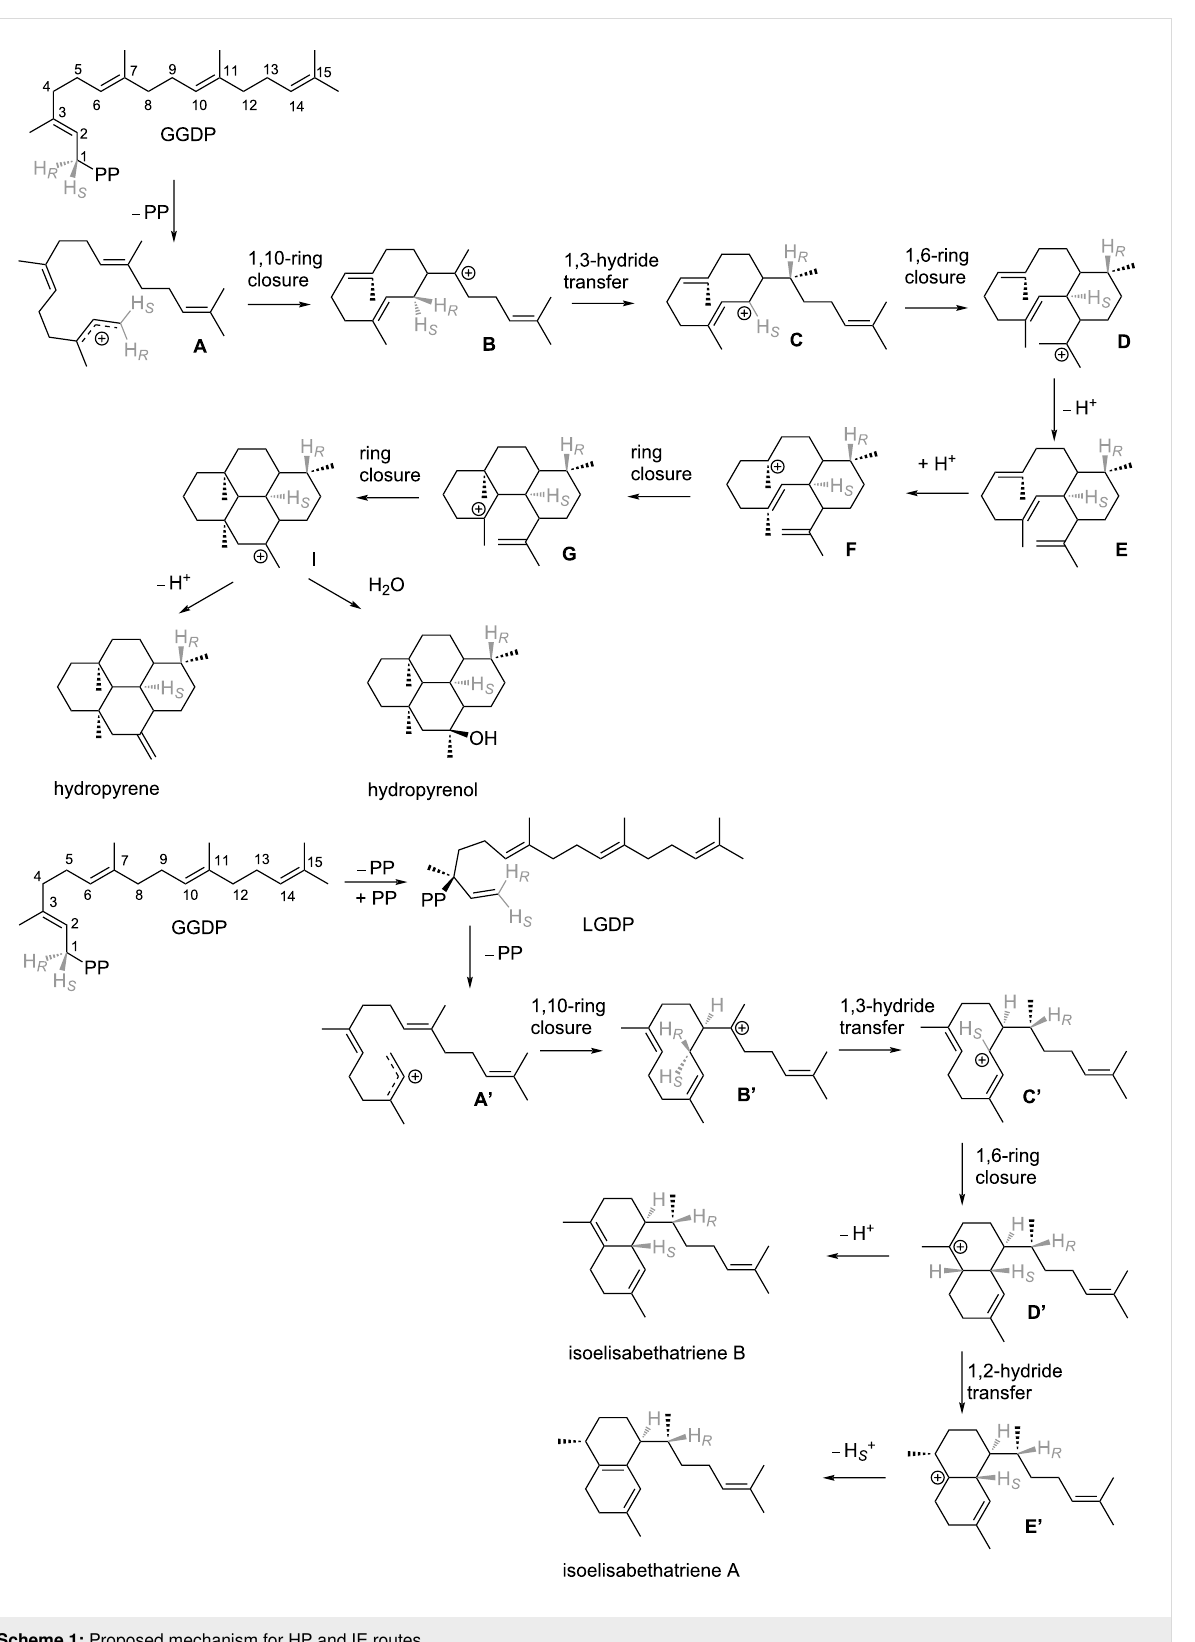
Scheme 1: Proposed mechanism for HP and IE